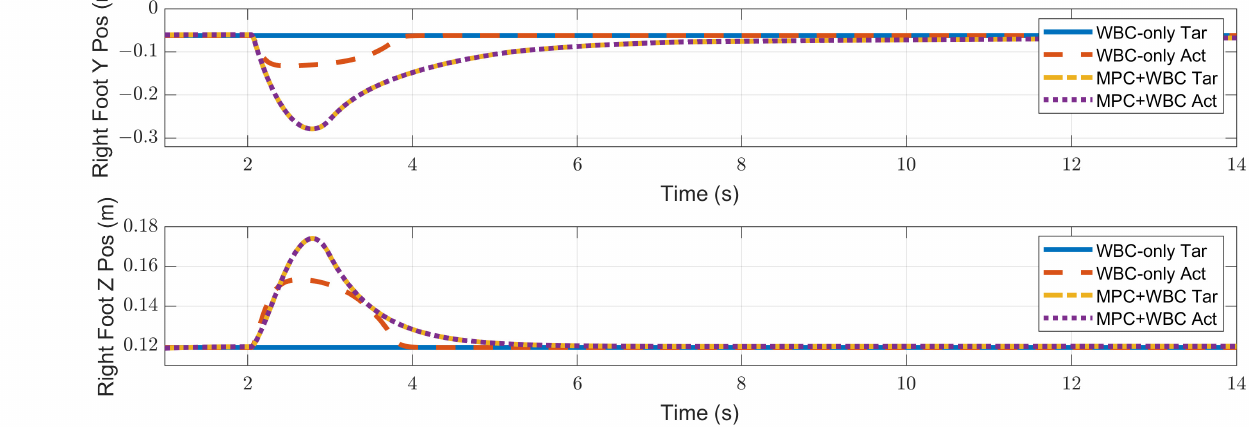
Figure 14. Swing foot position of the robot under the side impact of a 2.7 kg rigid